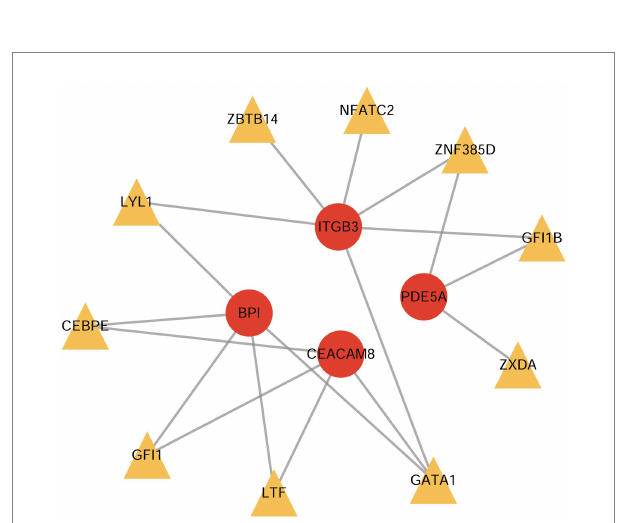
FIGURE 7 The TF-gene regulatory network constructed by hub shared genes and the top 10 predicted TFs. TF, transcription